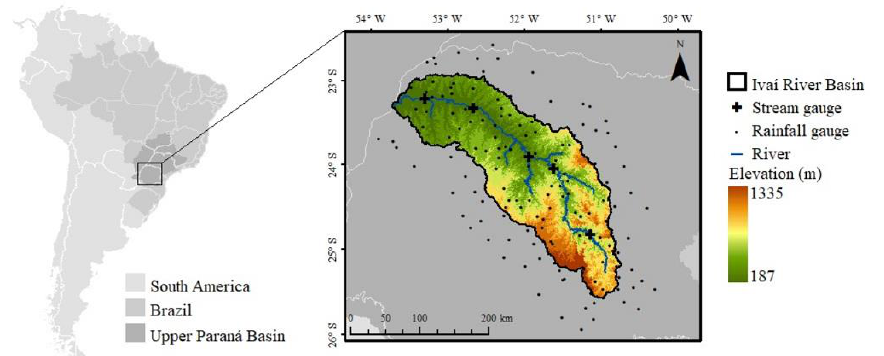
Figure 1. Localization map of the Ivaí River Basin within the Upper Paraná River Basin; elevation and rainfall stations are also identified.